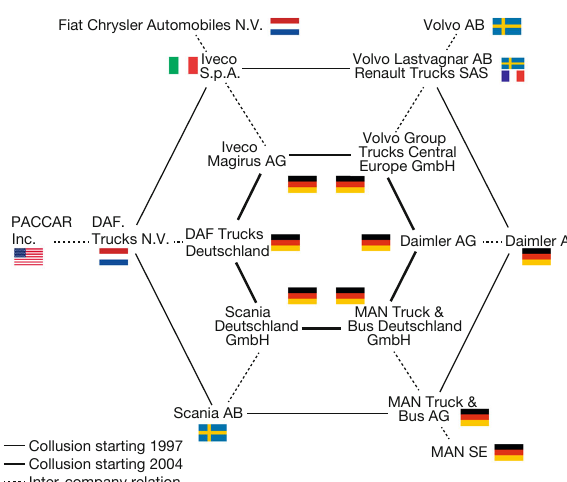
The structure of the European trucks